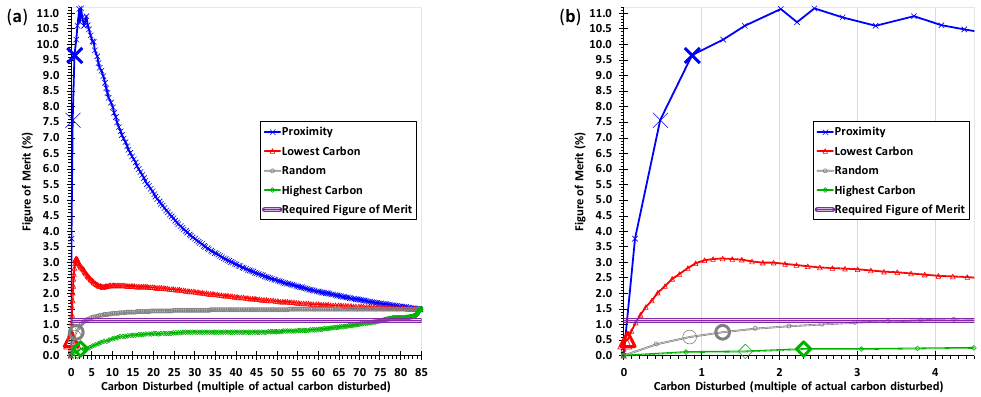
Figure 8. Figure of Merit versus carbon disturbed at ( a ) full range and ( b ) zoomed in.